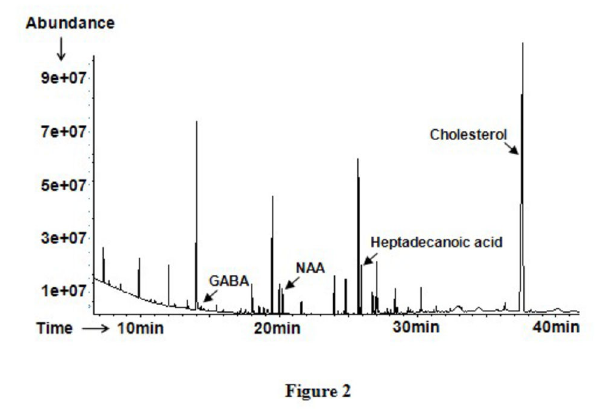
Figure 2. The typical GC–MS total ion chromatograms from PFC after chemical derivati-zaiton. The internal standard of heptadecanoic acid ion peak and selected maker peaks of GABA, NAA and Cholesterol were labeled above. doi: